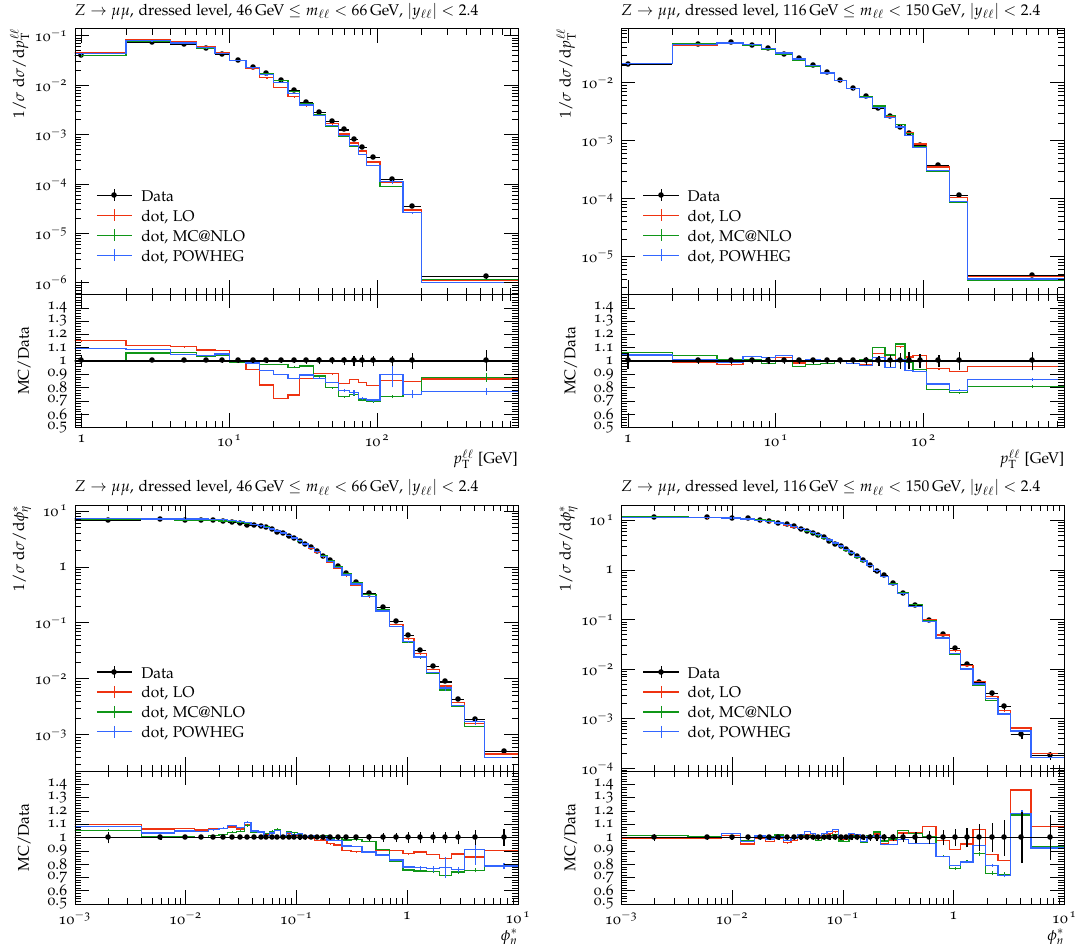
Figure 6 . Differential normalized cross section of Z → µ + µ − as a function of the Z transverse momentum (upper pane) and φ ∗ (low pane), below (left) and above (right) the Z mass peak region. η Herwig compared ATLAS [19] at 8